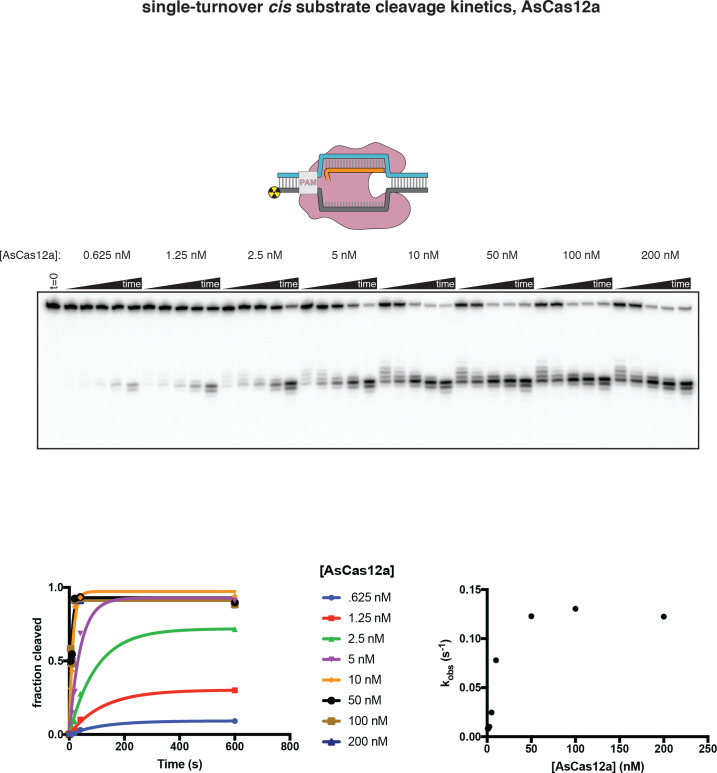
Enzyme-concentration dependence of AsCas12a cis DNA cleavage kinetics.250 pM of a cis duplex DNA target, radiolabeled on the 5' end of the NTS, was incubated with 240 nM crRNA and various concentrations of AsCas12a at 37°C for the following timepoints: 0 s, 5 s, 10 s, 20 s, 40 s, 10 m. ‘Fraction cleaved’ is defined as (sum of the volume of all bands below the uncleaved band)/(total volume in lane). Data were fit to an exponential decay (y = (y0-plateau)*exp(-k*x)+plateau), with y0 constrained to 0. At the lower values of [AsCas12a], an early plateau indicates an underestimation of the true enzyme concentration, due to loss of enzyme across extensive serial dilution. Despite this experimental deficiency, these data show that enzyme-substrate association is not rate-limiting when [AsCas12a] is 100 nM—that is, when [AsCas12a] is 100 nM, association can be approximated as instantaneous, and cleavage rate constants reflect unimolecular processes that follow binding. Based on these experiments, initial cis cleavage events occur at ~0.12 s−1 at the reagent concentrations used for cleavage mapping experiments. Considering the steady-state kinetic measurements in Appendix 2—figure 1—figure supplement 2, an upper limit on trans cleavage rate can be calculated as (kcat/KM)*[E], where [E] has an approximate upper limit of 10 nM (for radiolabeled-NTS experiments, in which cold TS is present at 10 nM, and assuming ssDNA-activated complexes have similar catalytic efficiency to dsDNA-activated complexes), yielding a rate of ~0.002 s−1 (>50 fold less than the cis cleavage rate). This trans cleavage rate estimate is an upper limit because radiolabeled DNA is mostly duplex and likely protected by the protein in non-duplex regions (Swarts et al., 2017). Thus, trans cleavage probably only occurs to a detectable extent on PAM-distal DNA fragments that are released from the enzyme following cis cleavage.